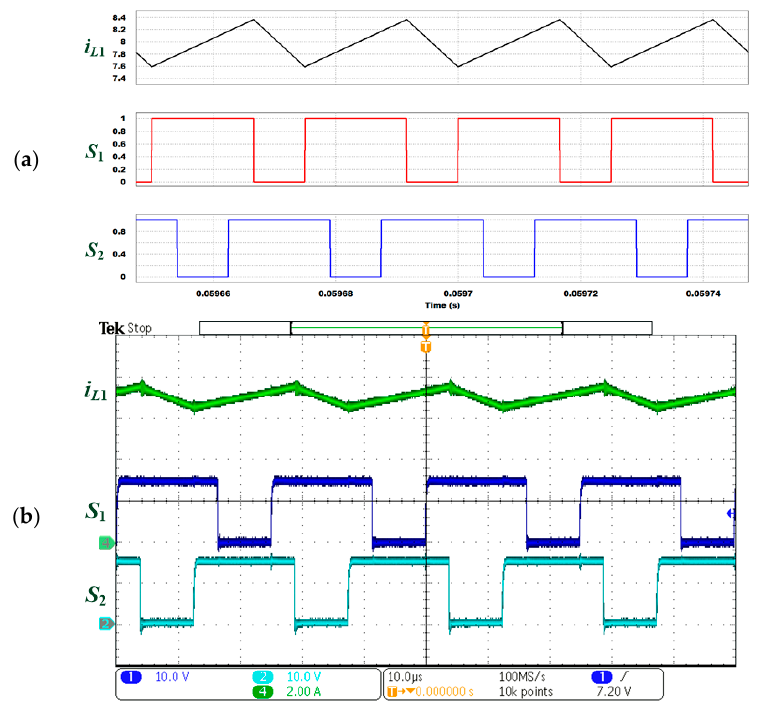
Figure 14. Waveforms of the combined boost converter for gate driving signals V gs1 and V gs2 and two-phase inductor current i L 1 . ( a ) Simulated waveforms; ( b ) Experimented waveforms.